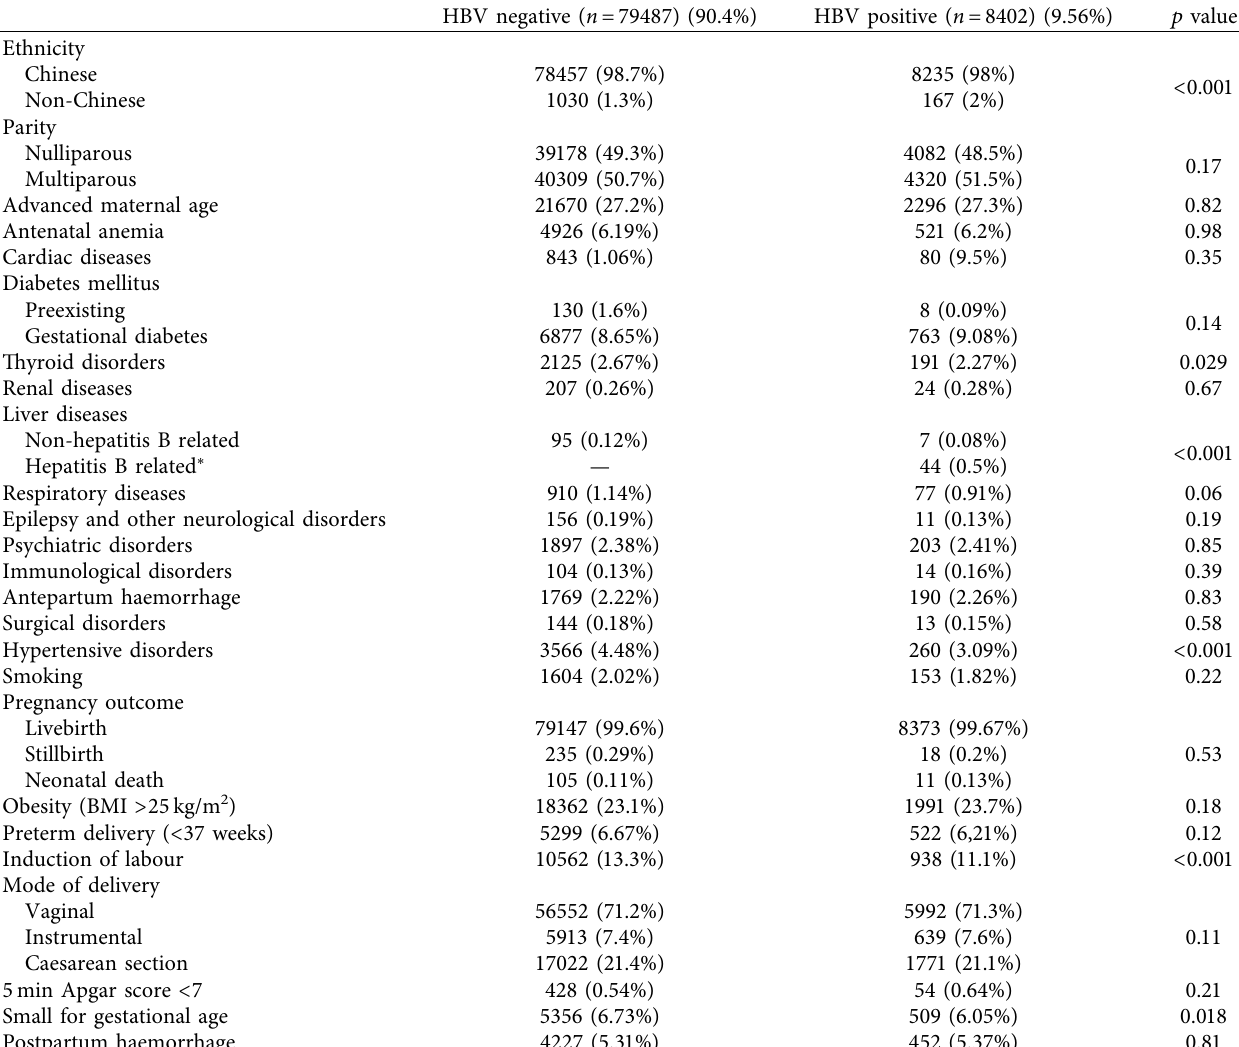
Table 2: Comparison of pregnancy complications and outcome between chronic hepatitis B carriers and